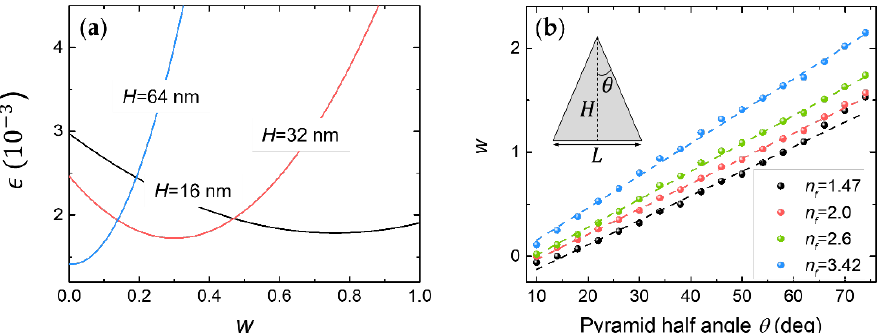
Figure 4. ( a ) The error function between FDTD and NLEM as a function of the weight parameter w for 3 different roughness heights. ( b ) The linear scaling of the weight factor w with pyramid half-angle (see inset) for the 4 different film indices considered.